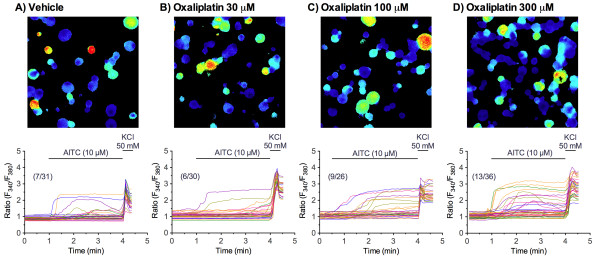
Oxaliplatin pretreatment increases the AITC-evoked Ca2+response in cultured DRG neurons. The cultured neurons were pretreated with vehicle ( A) or oxaliplatin at concentrations of 30 ( B), 100 ( C) or 300 μM ( D) for 2 h after which AITC (10 μM) was added for 3 min. Representative image of fluorescence (upper panels) and Ca2+ concentration (F340/F380 ratio) recorded in individual cultured DRG neuron (lower panels). All neurons in the fields were identified based on the [Ca2+]i increase elicited by the application of 50 mM KCl. Cell numbers in (AITC-sensitive DRG neurons)/(Total counted neurons) in the representative data are indicated in parentheses in lower panels.